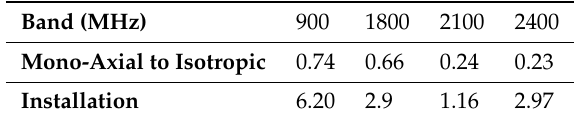
Table 5. Correction factors to be applied to the E-field samples.